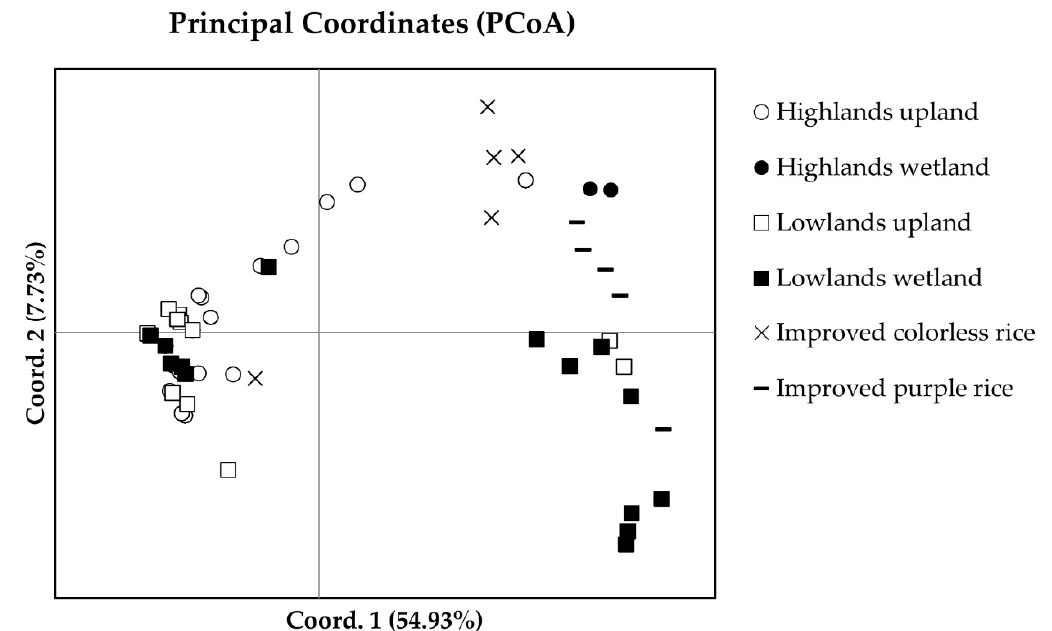
Figure 2. Principal coordinates based on the 16 SSR markers illustrated the distribution of thirty-seven purple rice landraces in northern Thailand and nine improved cultivars, by altitude and ecotype.